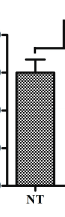
Figure 7. Effects of GLP-2 on microglia-mediated neurotoxicity. BV-2 cells were first treated with LPS